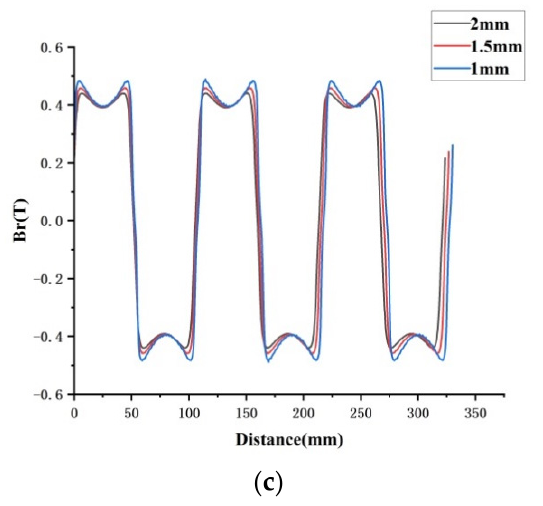
Figure 8. The influence of different thicknesses of permanent magnets on the radial component of air gap magnetic density: ( a ) 8 mm, ( b ) 10 mm, and ( c ) 12 mm.